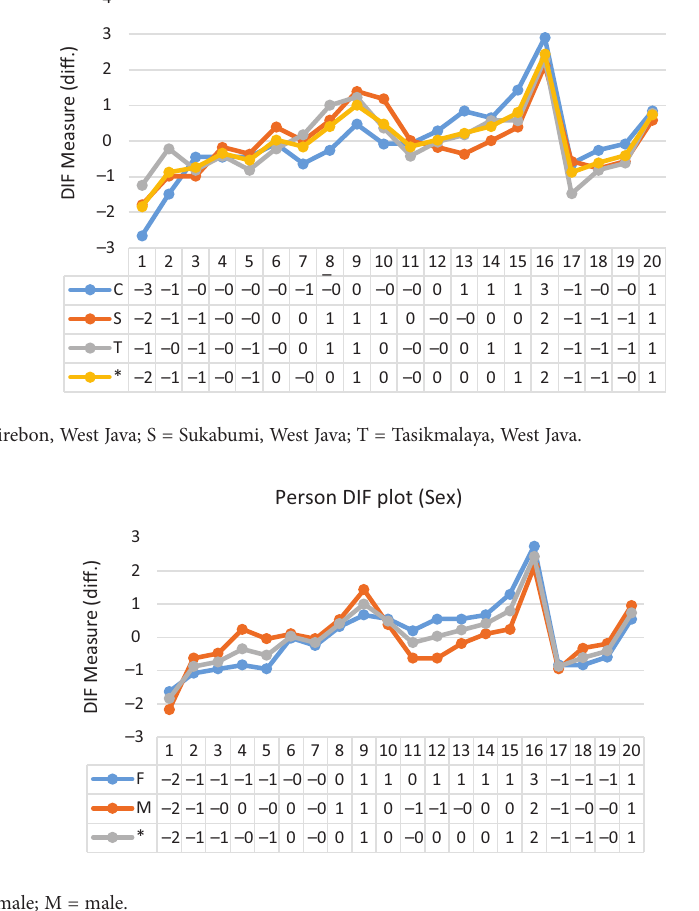
Figure 1. Differential item functioning graphic (source: created by